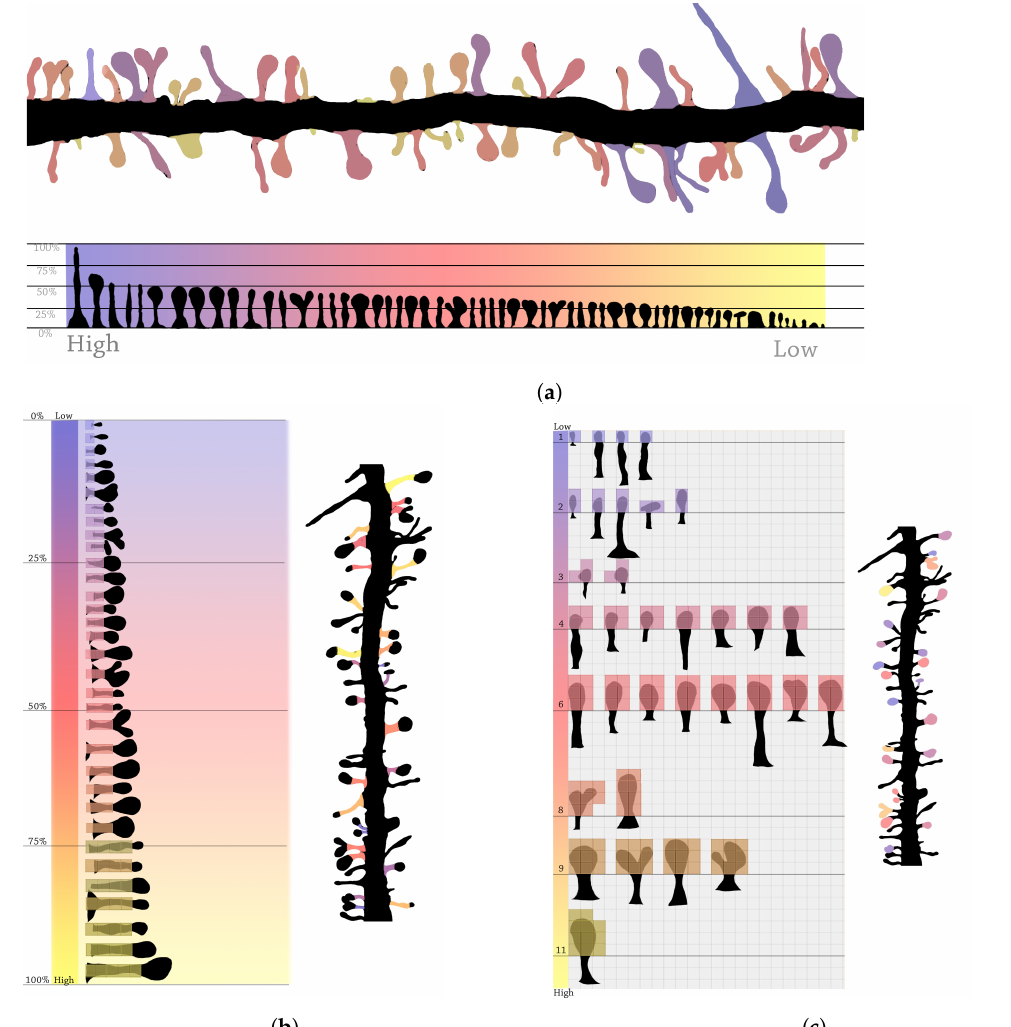
Figure 2. Spines from a selected dendrite segment. ( a ) Spines of a dendrite section ranked by total spine length; ( b ) Id., ranked by neck length; ( c ) Id., ranked by head